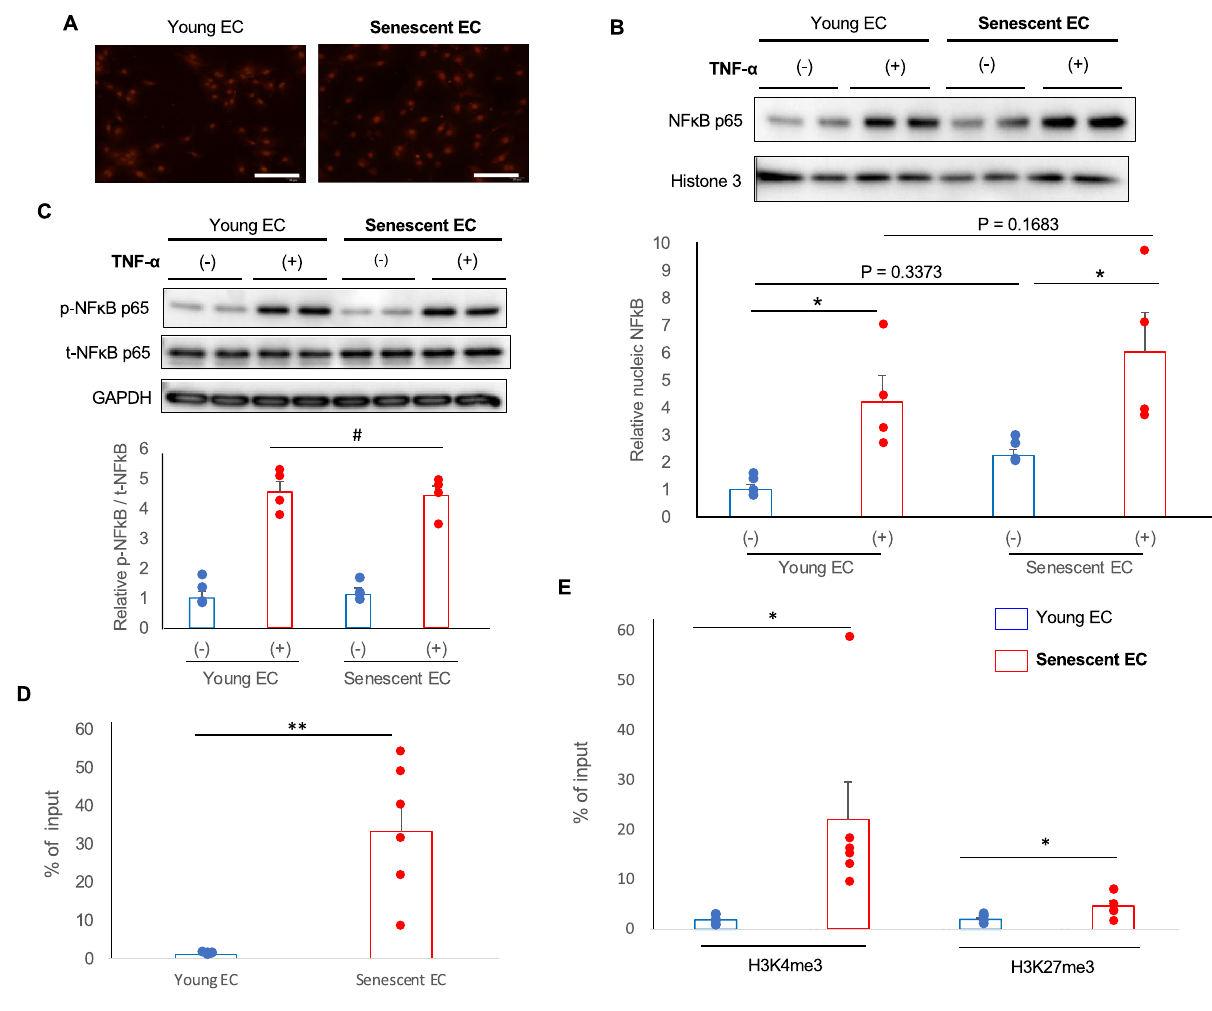
Figure 5. Epigenetic alteration causes the enhanced NF-κB signaling in senescent ECs. ( A ) Nuclear translocation of NF-κB p65 in response to TNF-α was assessed by immunocytochemistry. Bars: 200 μm. ( B ) Nuclear accumulation of NF-κB p65 in response to TNF-α was assessed by immunoblotting using nucleus extracts (n = 4 each). Blots cropped from different parts of the same gel were used. Uncropped blots images are shown in the Supplementary Fig. S3A. ( C ) Activation of NF-κB in response to TNF-α was assessed by immunoblotting for phospho-NFκB p65 (n = 4 each). For p-NF-κB and GAPDH, blots cropped from different parts of the same gel were used. For t-NF-κB, a blot prepared from the different gel (that was prepared using the same protein samples at the same time in parallel) was used. Uncropped blots images are shown in the Supplementary Fig. S3B. ( D ) NF-κB p65 binding to the promoter region for VCAM-1 was assessed by ChIP assay in young and senescent ECs treated with TNF-α (n = 6 each). ( E ) VCAM-1 gene association with histone H3 with activating (K4) or repressing (K27) trimethylation (me3) was assessed by ChIP assay (n = 6 each). Data are presented as mean ± SEM. * p < 0.05, and ** p < 0.01. #, not